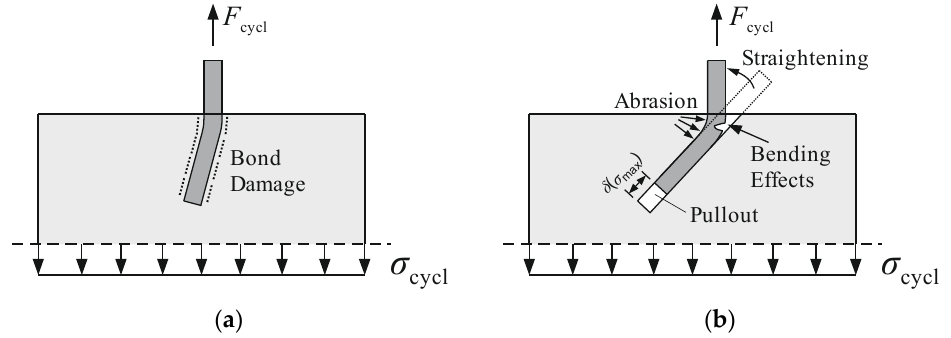
Figure 4. Damage processes of inclined fibres that might occur after cyclic loading: ( a ) Bond damage at an orientation of approximately 75° and ( b ) fibre damage at an orientation of approximately 45°.